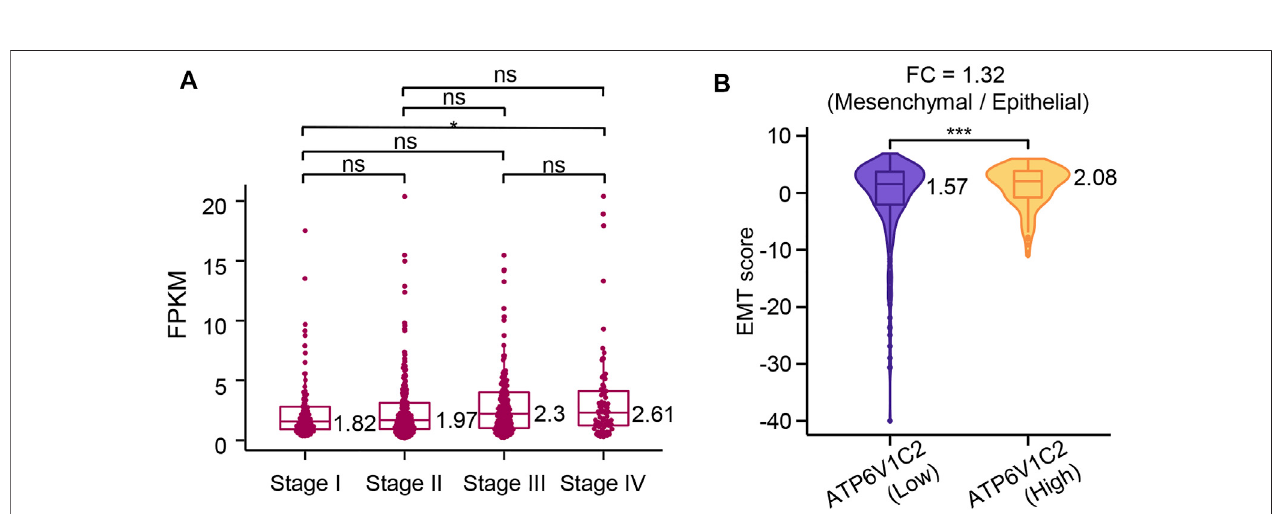
FIGURE 4 | The association of ATP6V1C2 expression with EMT process. (A) The difference in ATP6V1C2 expression level among patients with stage I, stage II, stage III, and stage IV; (B) The difference in EMT score between ATP6V1C2-high and -low groups. ns indicates p > 0.05. * indicates p < 0.05. *** indicates p < 0.001. EMT, epithelial – mesenchymal transition. FPKM: Fragments per kilobase of exon model per million mapped fragments; FC: fold change; EMT: epithelial – mesenchymal transition.